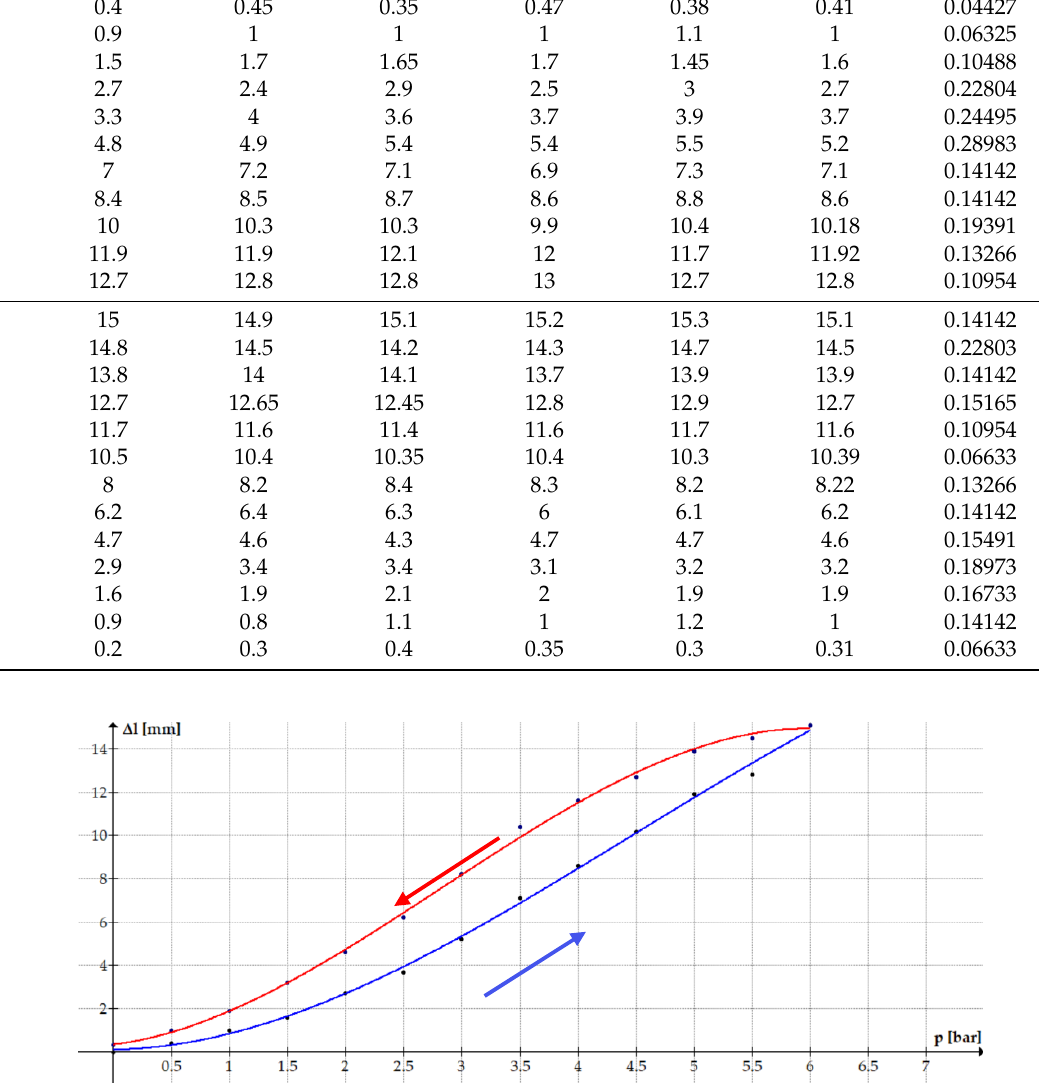
Figure 5. Polynomial regression curve: inflation. The polynomial regression that best fits the measured values for inflation is one of a third degree, as seen in Equation (1): ∆𝑙 (cid:3036)(cid:3041)(cid:3033)(cid:3039)(cid:3028)(cid:3047)(cid:3036)(cid:3042)(cid:3041) = 0.096 + 0.079 ∙ 𝑝 + 0.718 ∙ 𝑝 (cid:2870) − 0.053 ∙ 𝑝 (cid:2871) (1) The parameters of the regression were found using a specialized software, the Curve Expert Professional v. 2.7, and based on the measured values. The correlation coefficient ( r ) is 0.999 and the coefficient of determination ( r 2 ) is 0.998. Those values validate the func- tion. In Figure 6, the polynomial regression is presented, which best fits the obtained re- sults at deflation.